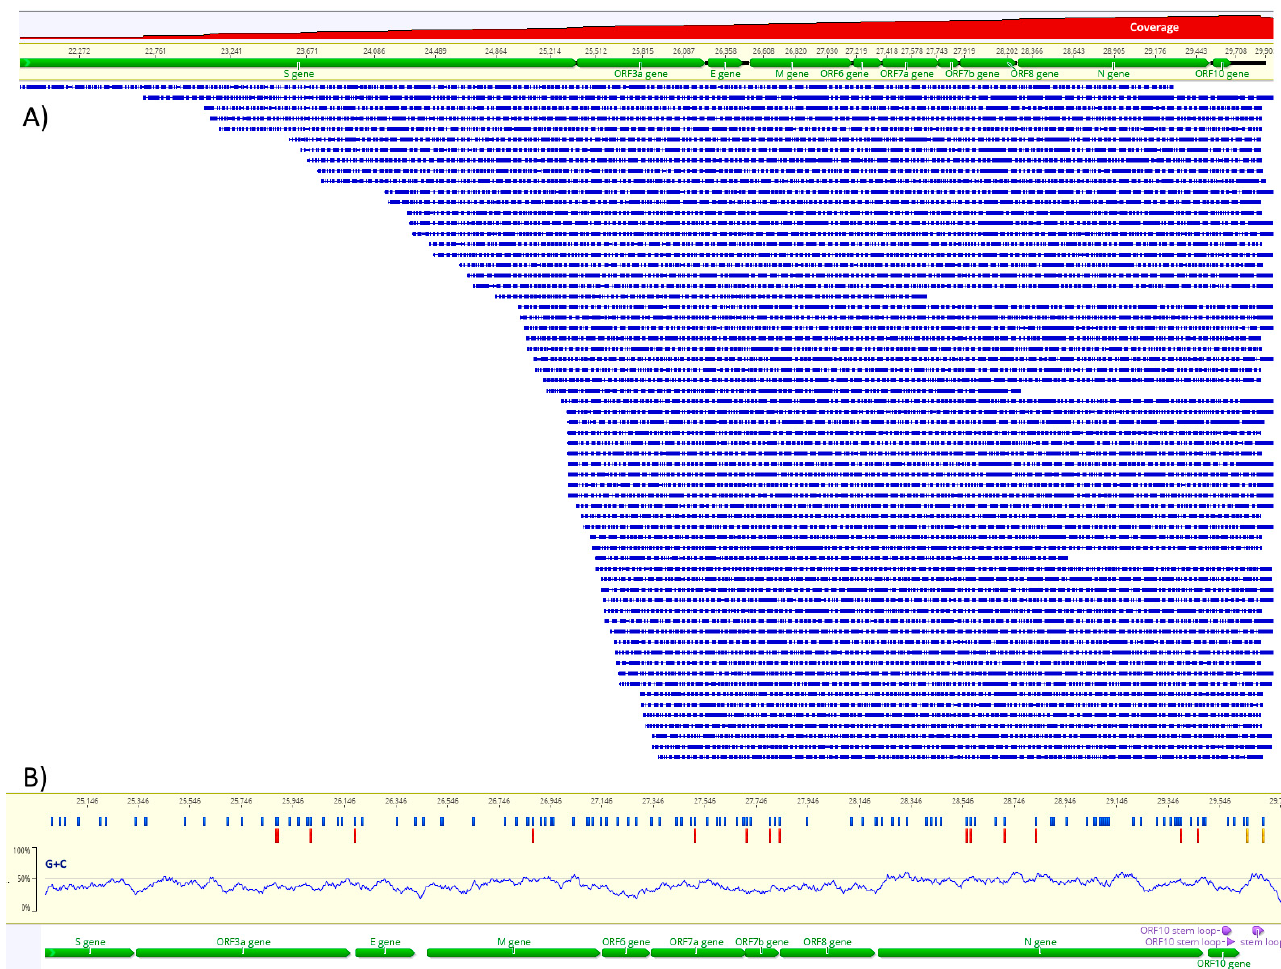
Figure 1. Assembly of Nanopore direct RNA reads to the reference sequence ( A ) and map of m6A methylation probability along the SARS-CoV-2 RNA ( B ). In ( A ), green horizontal bars indicate the ORFs, blue horizontal bars of decreasing size indicate the Nanopore reads and the red area at the top indicates the log scale coverage from 1 × to 1600 × . In ( B ), blue vertical bars indicate the DRACH motifs, red vertical bars indicate m6A (>50% probability) and the yellow vertical bars indicate two potential m6A with probabilities 0.38 and 0.44 in the 3 ′‐ untranslated region. The G + C content is indicated in the plot just above the annotation.